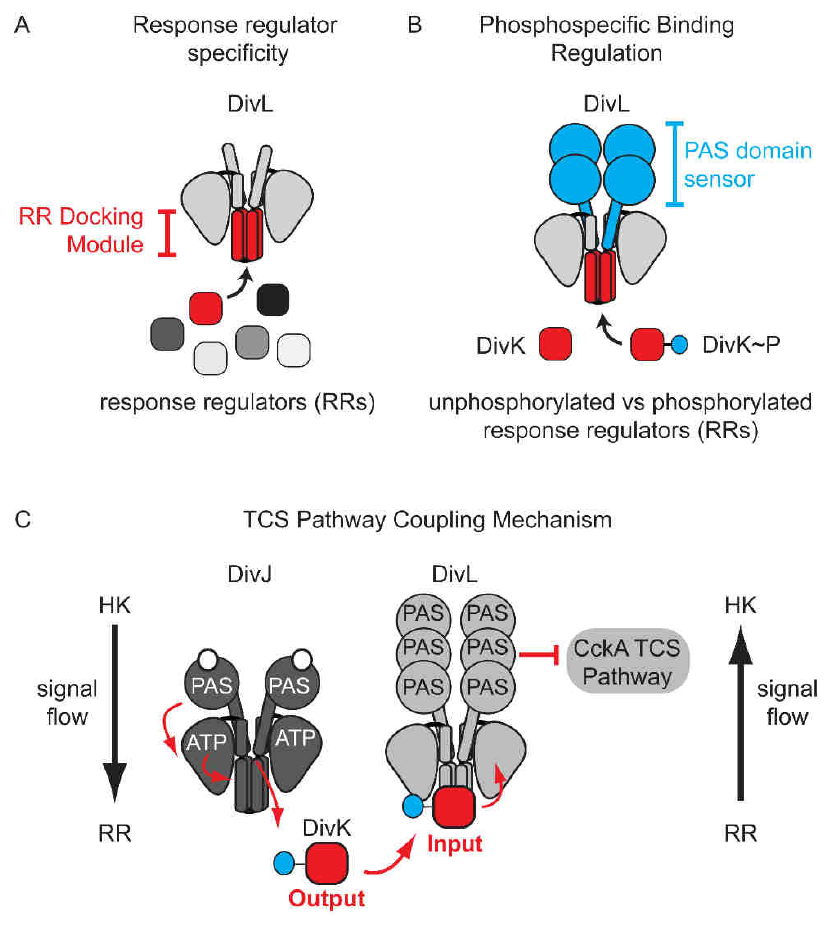
FIGURE 2: Factors that program complex signal wiring of two-component